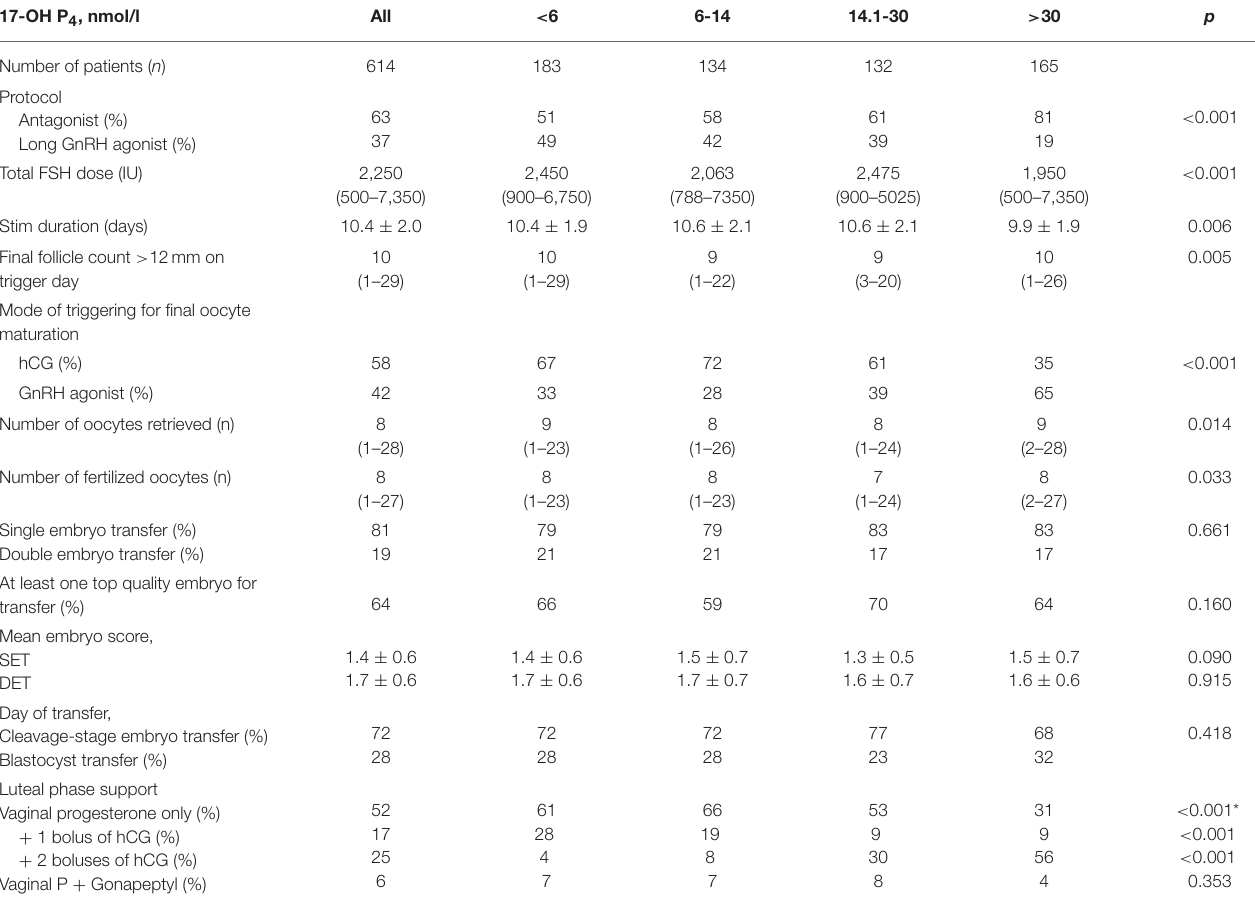
TABLE 2 | Descriptive data of controlled ovarian stimulation, oocytes, embryo transfer, and luteal phase